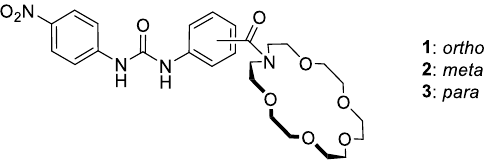
Figure 1. Structures of studied regioisomeric heteroditopic receptors 1 – 3 .